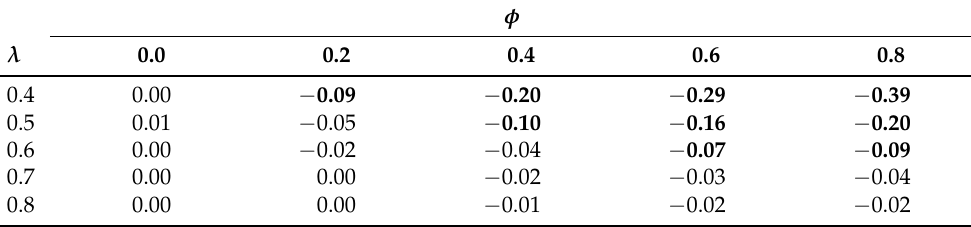
Table 4. Focused Simulation Study 1B (two factors and residual correlations): bias for the LSAM estimation approach of estimated factor correlation with a sample size N = 100 and no residual correlations in the data-generating model as a function of the factor loading λ and the true factor correlation φ